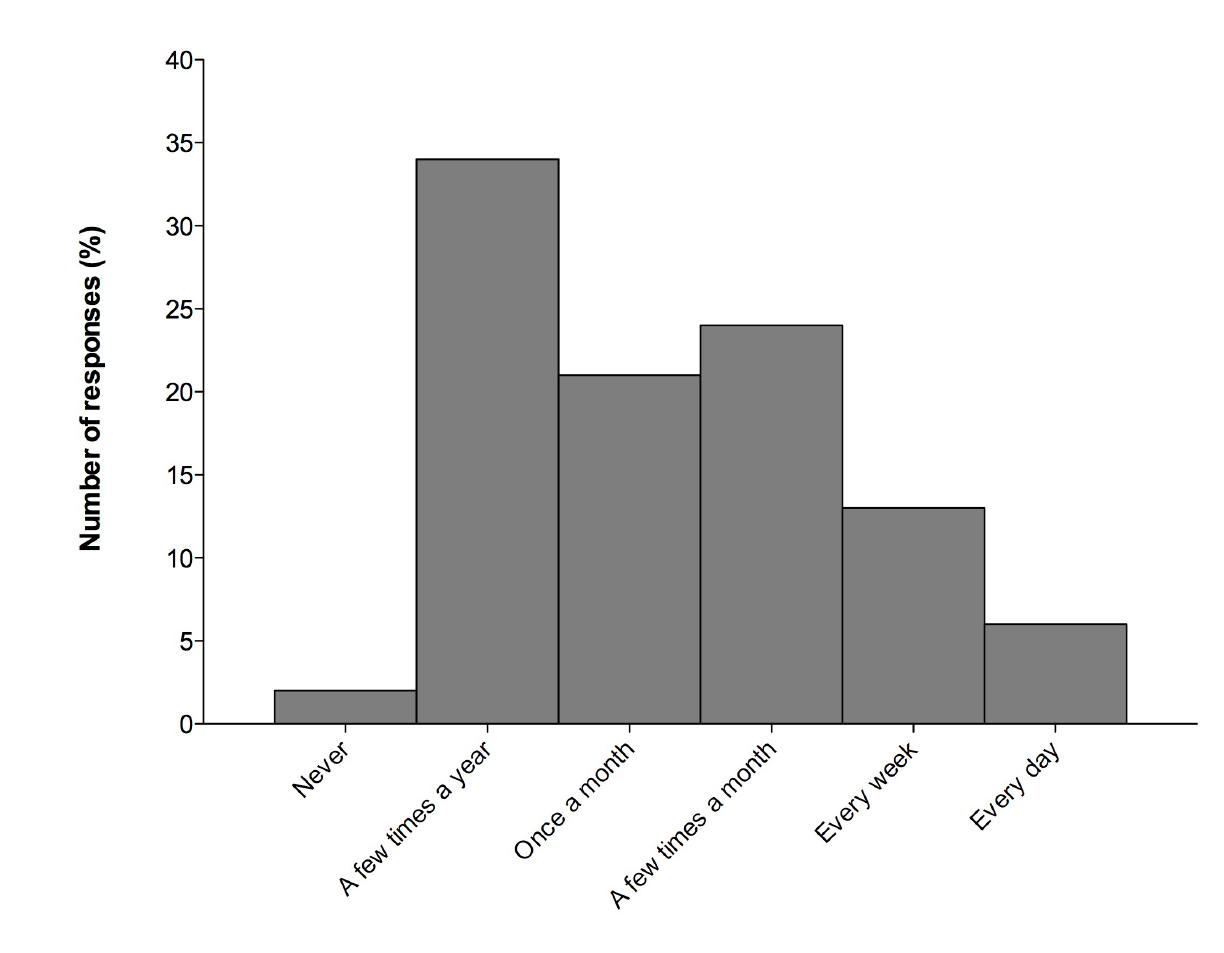
Figure 2. Frequency of Internet use for health related